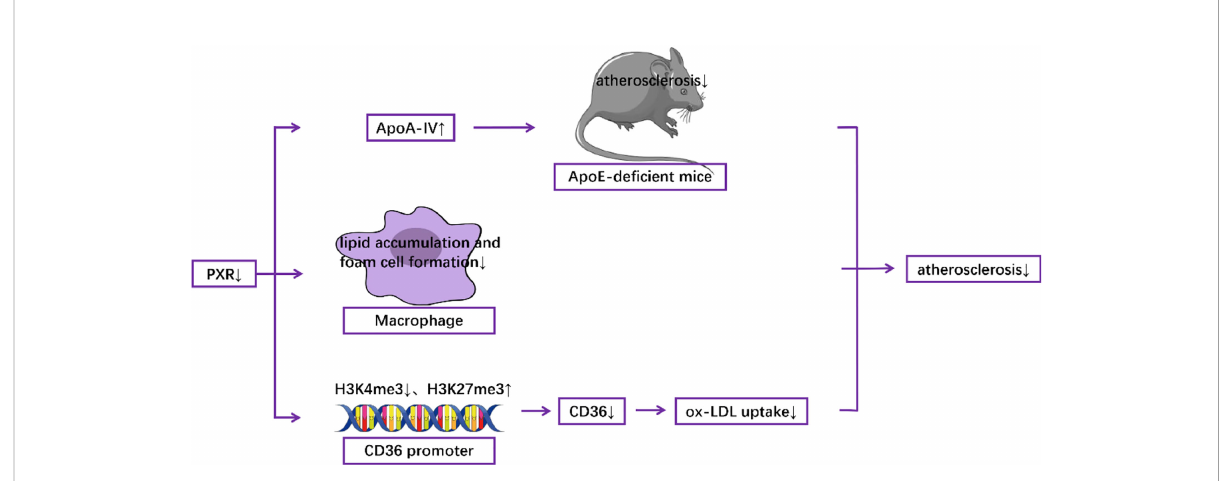
FIGURE 3 Mechanisms underlying the role of PXR in the pathogenesis of